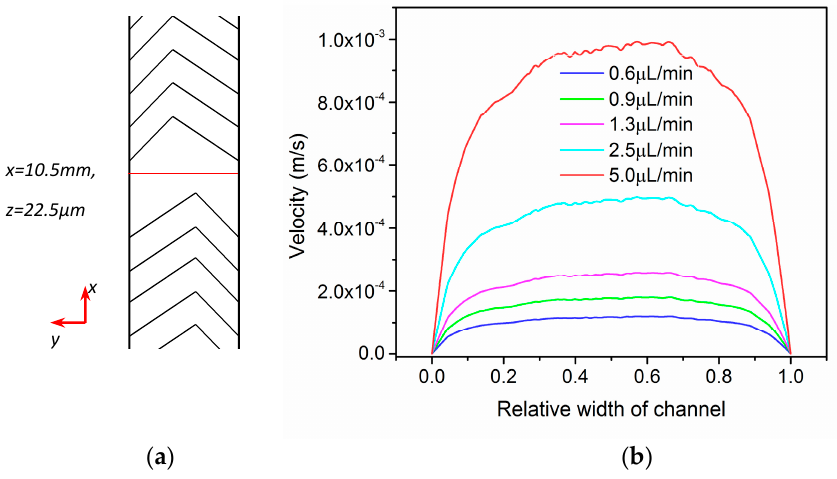
Figure 2. ( a ) Description of the middle position, ( b ) Velocity comparison at middle position of main channel in pressure driven flow.